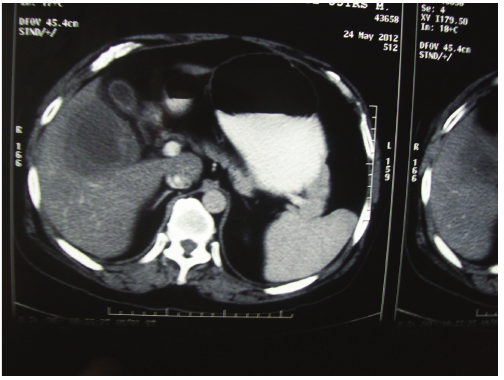
Figure 1: CECT abdomen showing right lobe liver abscess and edematous